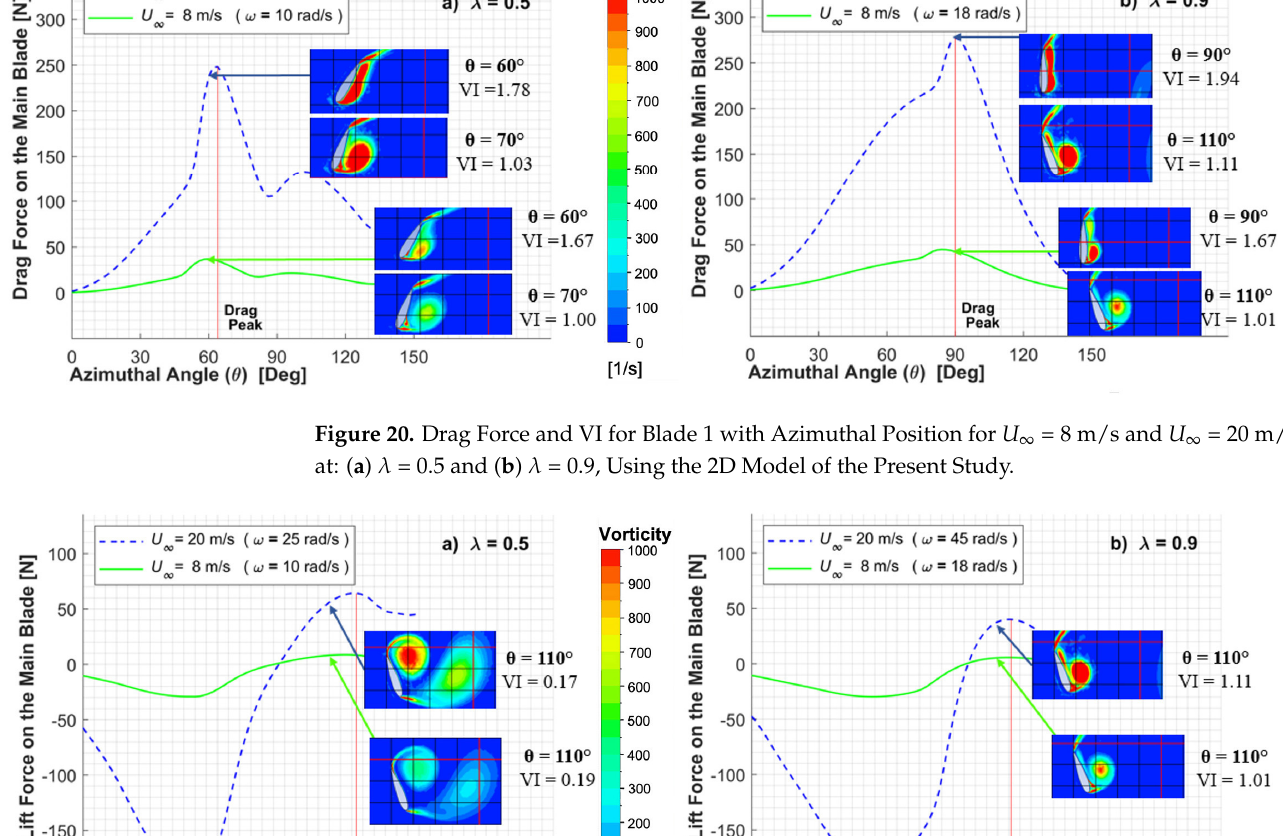
Figure 21. Lift Force and VI for Blade 1 and VI with Azimuthal Position for U ∞ = 8 m/s and U ∞ = 20 m/s at: ( a ) λ = 0.5 and ( b ) λ = 0.9, Using the 2D Model of the Present